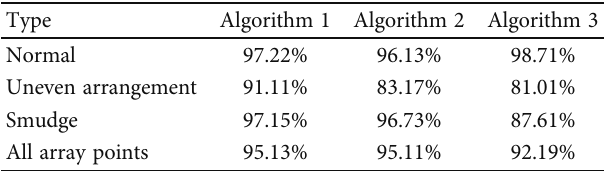
Table 3: Segmentation accuracy of colorimetric sensor arrays. Type Algorithm 1 Algorithm 2 Algorithm 3